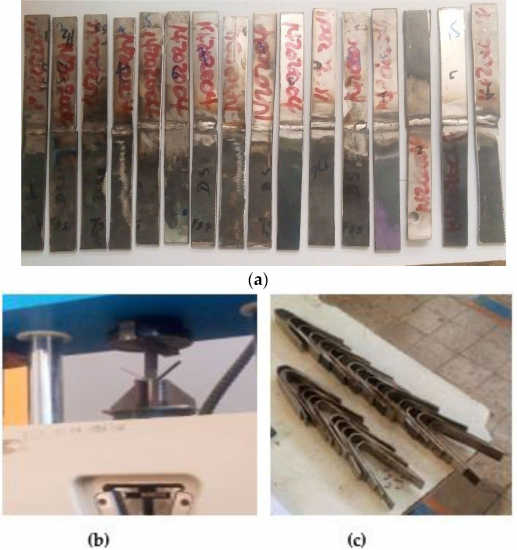
Figure 12. Specimens: ( a ) before testing, ( b ) specimen under 3-point flexural testing, and ( c ) speci- mens after